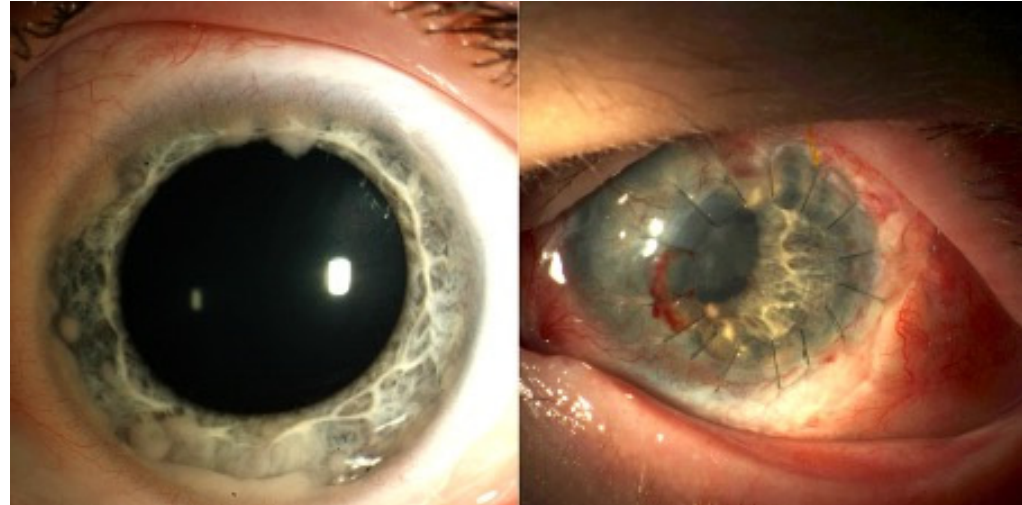
* = enucleation unavoidable before completion of the requested 12 months of follow up after termination of PBT; IVitC = intravitreal chemotherapy; IAC = intra-arterial chemotherapy; IOL = intraocular lens; pKPL = penetrating keratoplasty; AMT = amniotic mem- brane transplant.